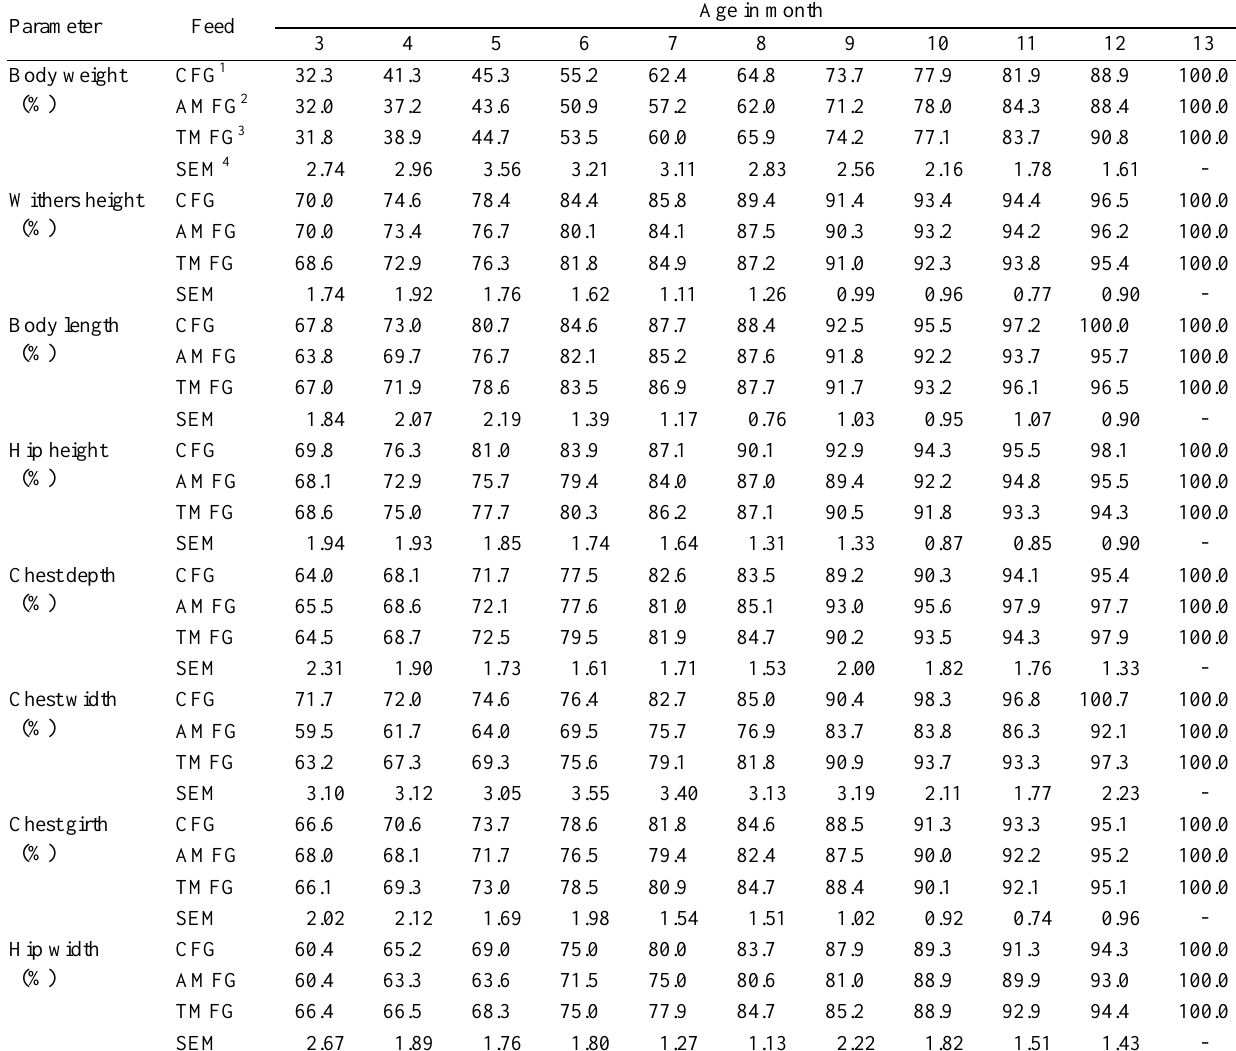
Table 9. The growth percentage of body parameters based on the measurements taken throughout the experiment Parameter Feed Body